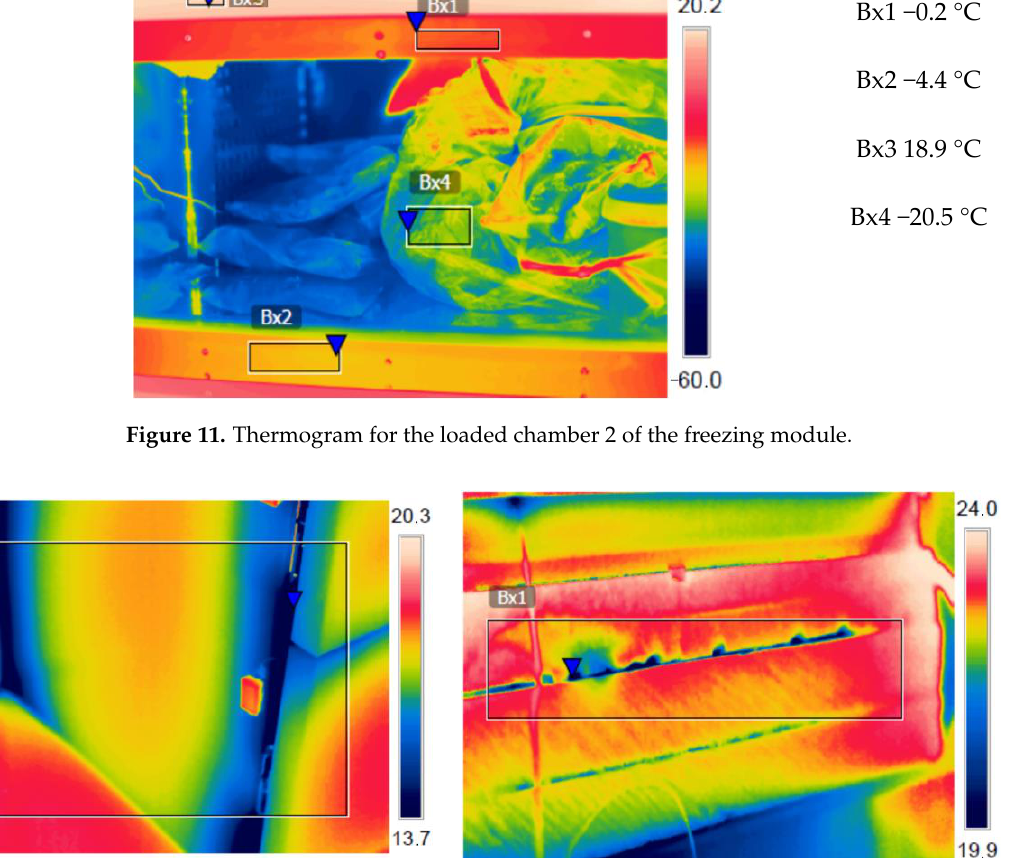
Figure 10. Thermogram for the loaded chamber 2 of the cooling module .